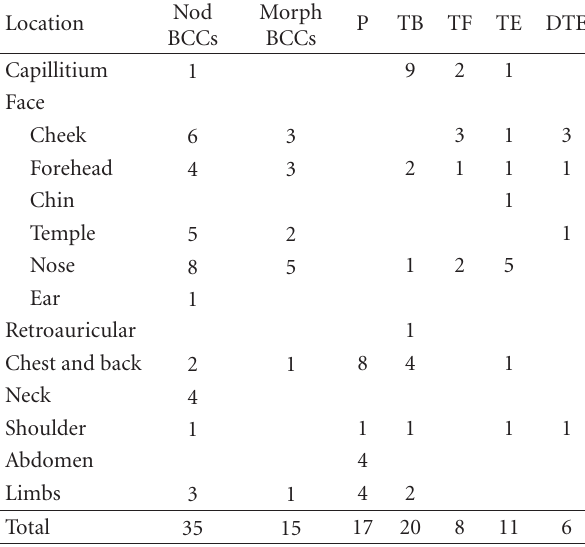
Figure 1: Boxplot for the microvessel counts in peritumoral stroma, tumor, and normal